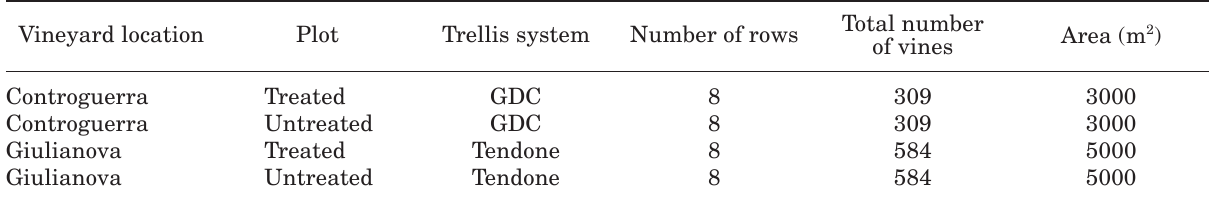
Table 2. Plot details in the vineyards evaluated. Vineyard location Plot Trellis